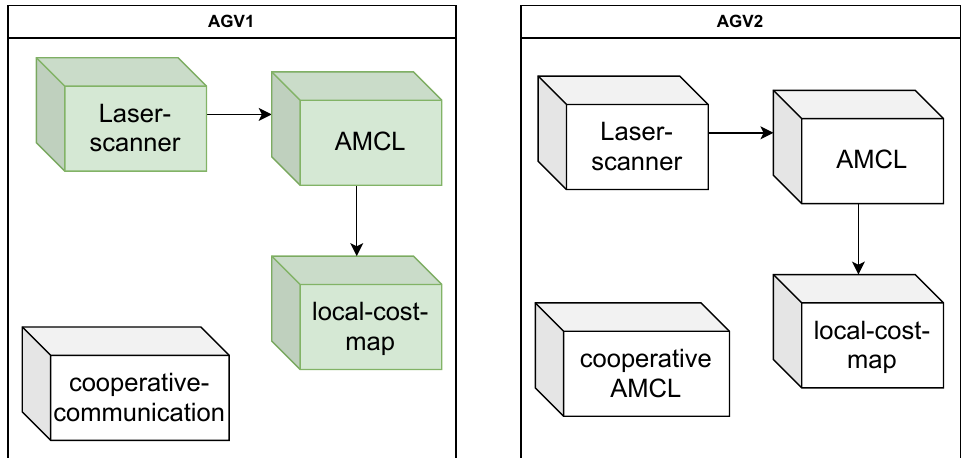
Figure 3. Service and communication setup in normal operation of AGV1 and AGV2 (green: services used by